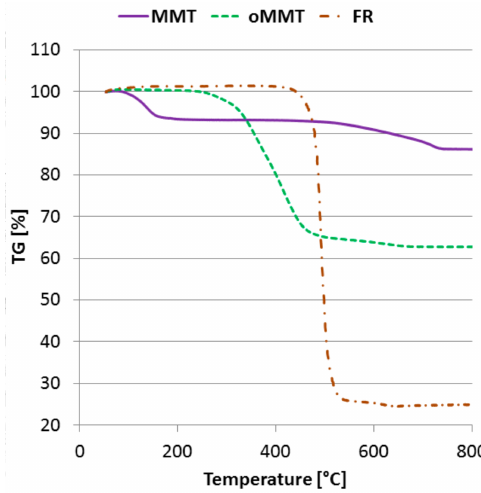
Figure 4. Thermogravimetric curves of the additives (N 2 atmosphere, 20 ◦